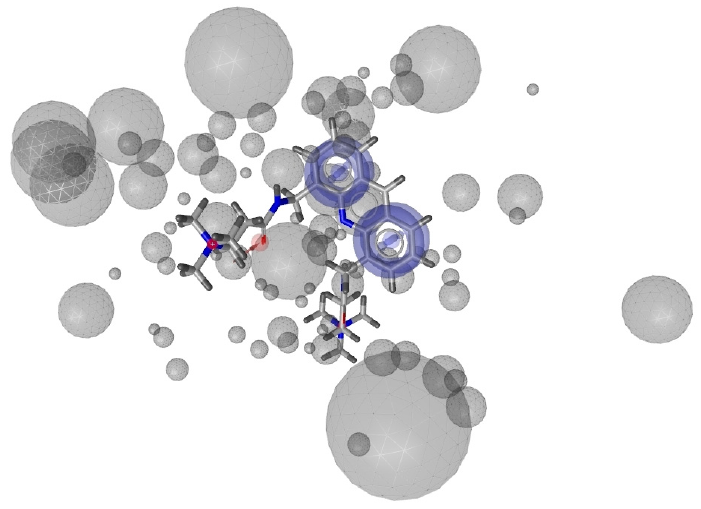
Figure 5. Representation of the pharmacophore H_9 generated starting from the 4FXM PDB model by LigandScout